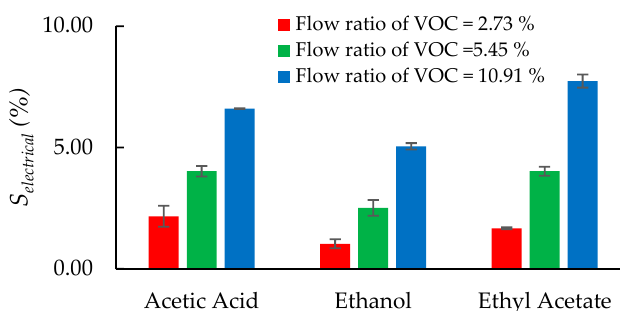
Figure 5. The dynamic response of the sensor’s equivalent resistance ( a )–( c ) towards flow ratios of 2.73%, 5.45%, and 10.91% of ethanol, acetic acid, and ethyl acetate VOC molecules, respectively. The flow ratio variation of the VOC is shown in the secondary vertical axis. A value of V ratio = 0 indicates the absence of VOC molecules in the flow.